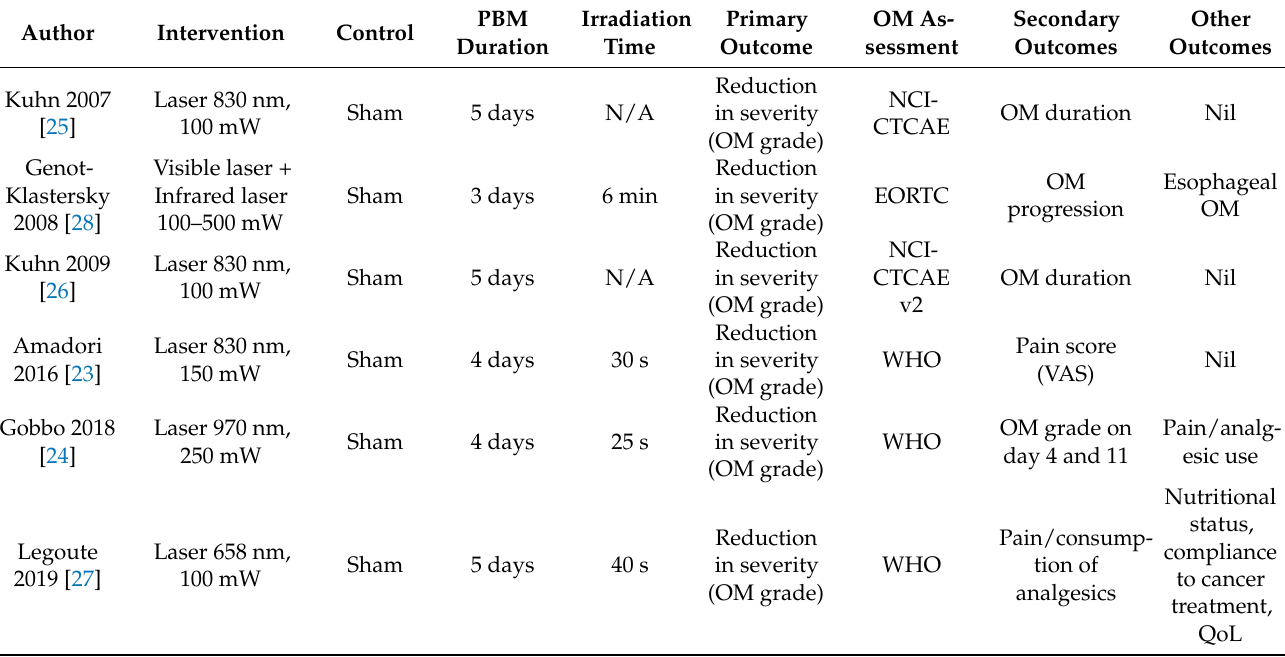
Table 1. Population characteristics of studies included in the meta-analysis. RCT: randomized control trial, CT: chemother- apy, RT: radiotherapy, OM: oral mucositis, QoL: quality of life, NCI-CTC AE: National Cancer Institute—Common terminol- ogy criteria for adverse events, EORTC: European Organization for research and treatment for cancer scale, WHO: World Health Organization, Sham: placebo